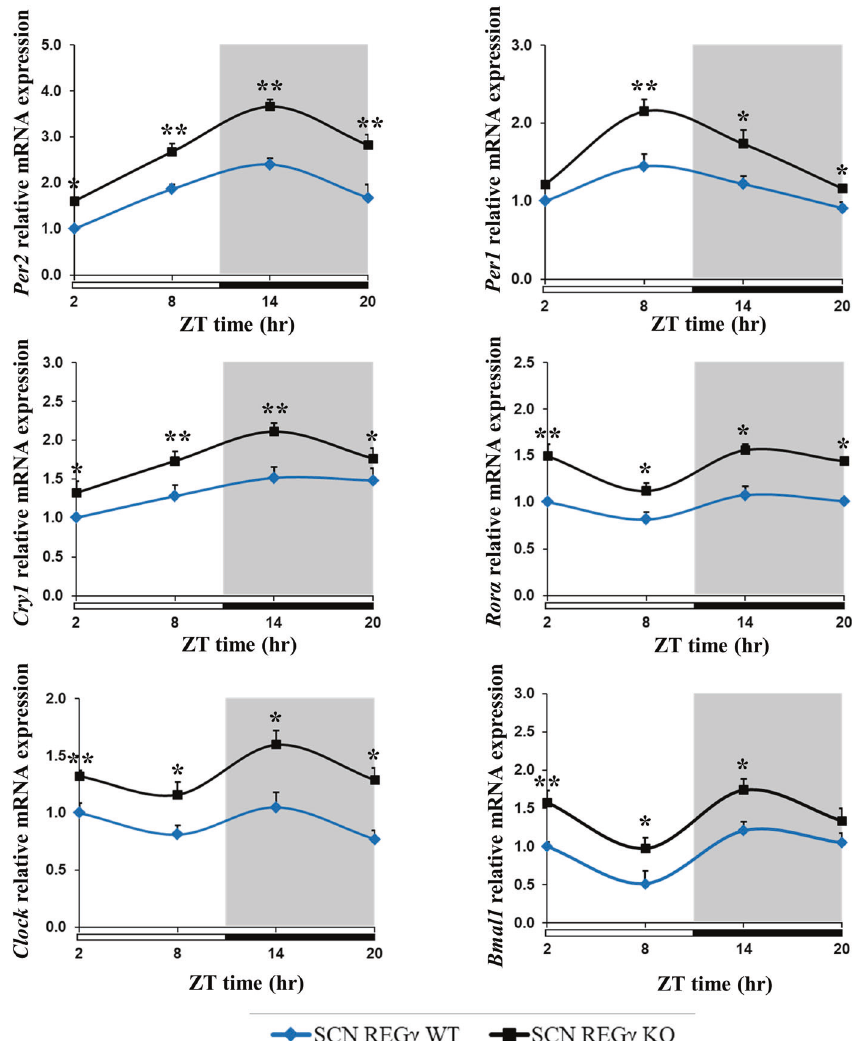
Fig. 2 REG γ de fi ciency promotes the expression of circadian clock-speci fi c genes in SCN. Real-time qPCR analysis of clock-speci fi c genes including Per1 , Per2 , Cry1 , Clock , Bmal1 , and Ror α in REG γ WT and KO mice SCN. REG γ WT and REG γ KO mice were entrained to 12/12 h LD cycle, then sacri fi ced the mice at 6 h intervals on the last day of the cycle and the anterior hypothalamus tissues that contain the SCN were collected for mRNA analysis. Values represent the mean ± SD. ** p < 0.01, * p < 0.05; t test, WT vs. KO. (Fig. S4C, D), compared to control cells untreated with inhibitor (Fig. S4A, B). To substantiate the mechanism by which REG γ regulates circadian physiology via proteasomal degradation of BMAL1, we treated SY5Y cells with the small interfering RNA (siRNA) against Bmal1 (si- Bmal1 ) and the control siRNA (si-Ctrl). Silencing Bmal1 markedly decreased the expression of PER2 protein both in SY5Y ShN and ShR cells, attenuating the effect of BMAL1 and PER2 upregulation induced by REG γ knockdown (Fig. 5C). Consequently, ablation of Bmal1 not only blocked the effect of REG γ depletion on circadian gene activation in ShR cells but also repressed overall expression of Per1 , Per2 , and Cry1 genes in SY5Y ShN cells (Fig. 5D). These results indicate that REG γ inhibition is a previously unknown mechanism regulating circadian biology via controlling the homeostasis of BMAL1.